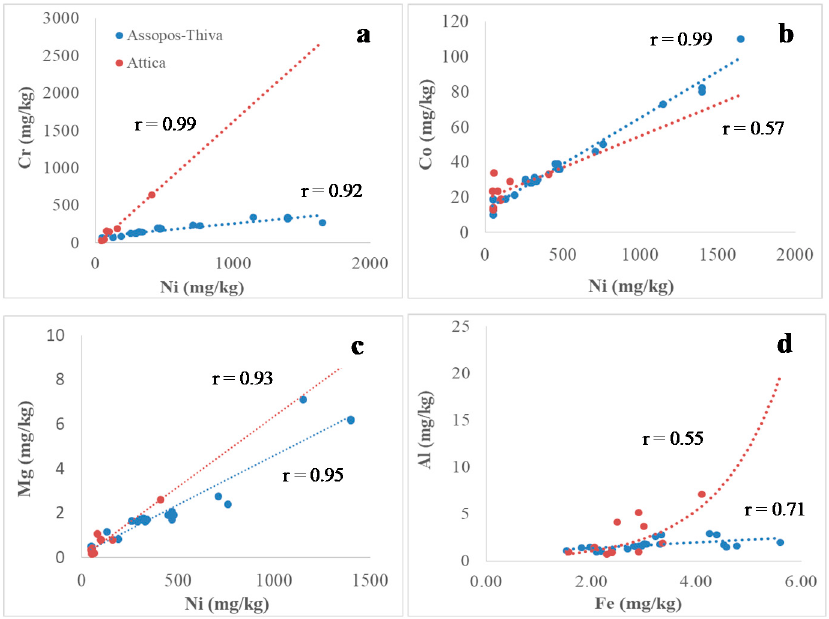
Figure 2. Plot of the Ni versus Cr, Co and Mg ( a – c ) and Al vs Fe contents in soils from the Assopos–Thiva and Attica basins. Data from Table 1. ( a ) Cr vs. Ni; ( b ) Co vs. Ni; ( c ) Mg vs. Ni; ( d ) Al vs. Fe.